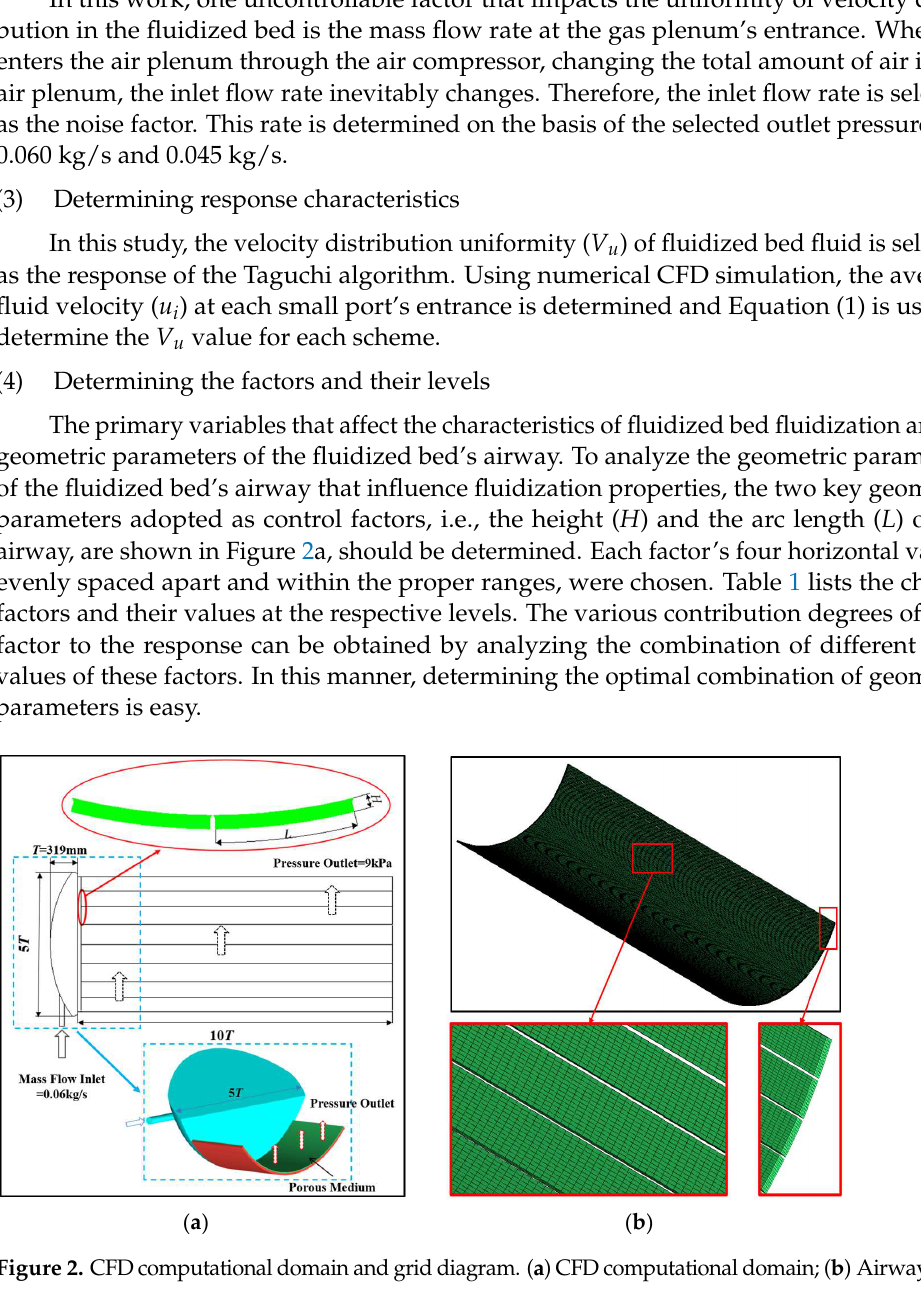
23 Table 2. L16 orthogonal array table. Trial